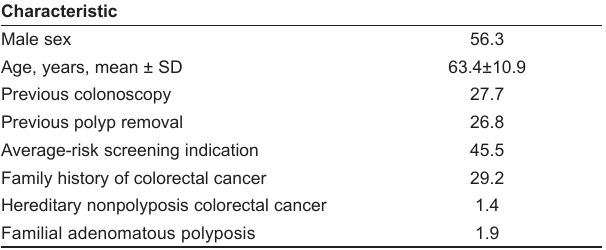
Table 2 Characteristics and findings of screening